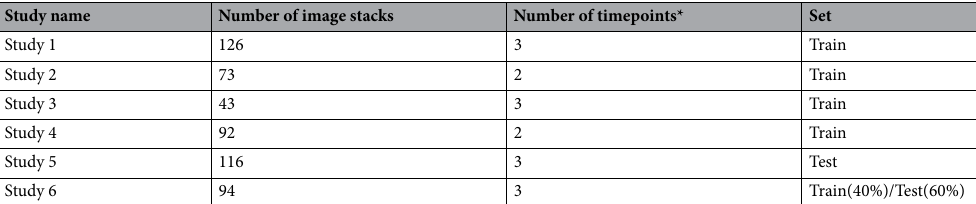
Table 1. Summary of rat heart longitudinal study image segmentation datasets used in the experiments. *Number of follow-ups within the longitudinal study. In presented studies the timepoints were separated by a 3-month